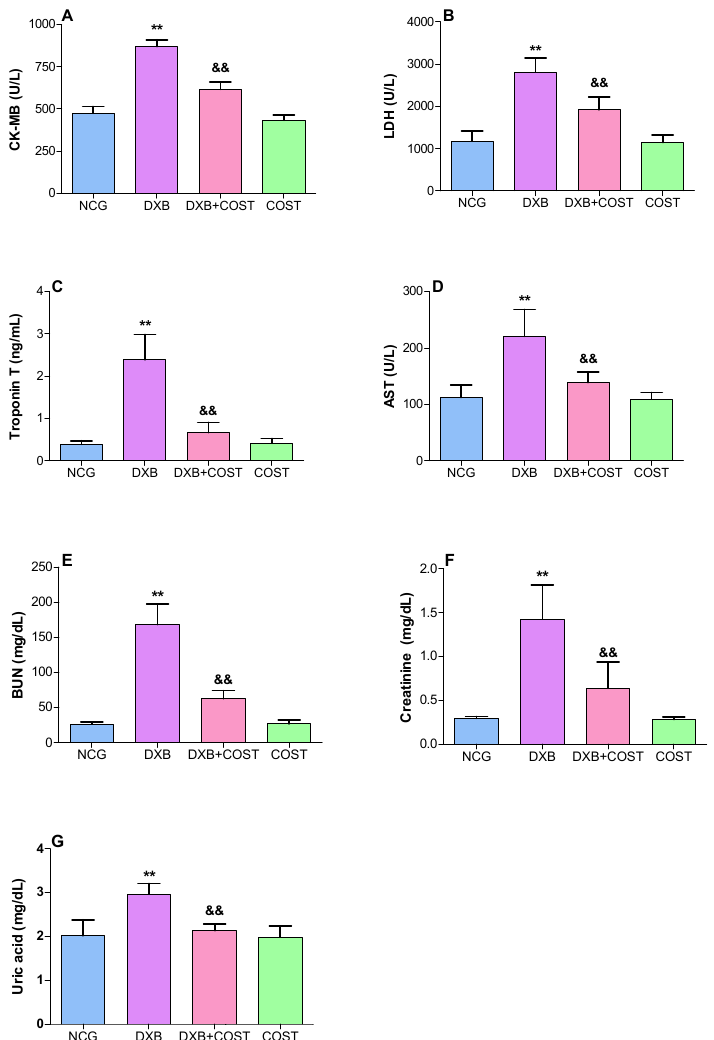
Figure 2. Effect of costunolide on: ( A ): CK-MB, ( B ): LDH, ( C ): Troponin T, ( D ): AST, ( E ): BUN, ( F ): creatinine, ( G ): uric acid. ** Statistically significant ( p < 0.01) compared with NCG and COST groups. && Statistically significant ( p < 0.01) compared with DXB group.